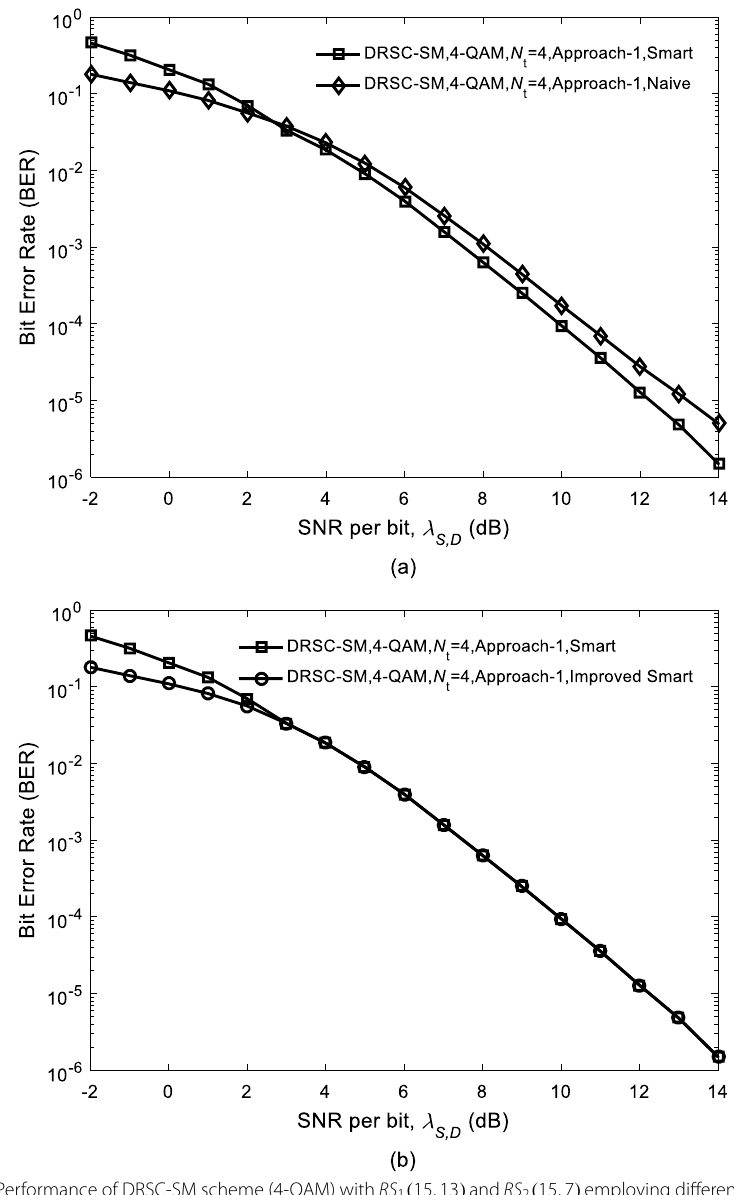
Fig. 9 Performance of DRSC-SM scheme (4-QAM) with RS 1 ( 15,13 ) and RS 2 ( 15,7 ) employing different algorithms. In Fig. 9a, the solid line with diamond mark denotes the BER performance of DRSC-SM scheme employing naive algorithm. The solid line with square mark denotes the BER performance of DRSC-SM scheme employing smart algorithm. In Fig. 9b, the solid line with circle mark denotes the BER performance of DRSC-SM scheme employing improved smart algorithm. The solid line with square mark denotes the BER performance of DRSC-SM scheme employing smart